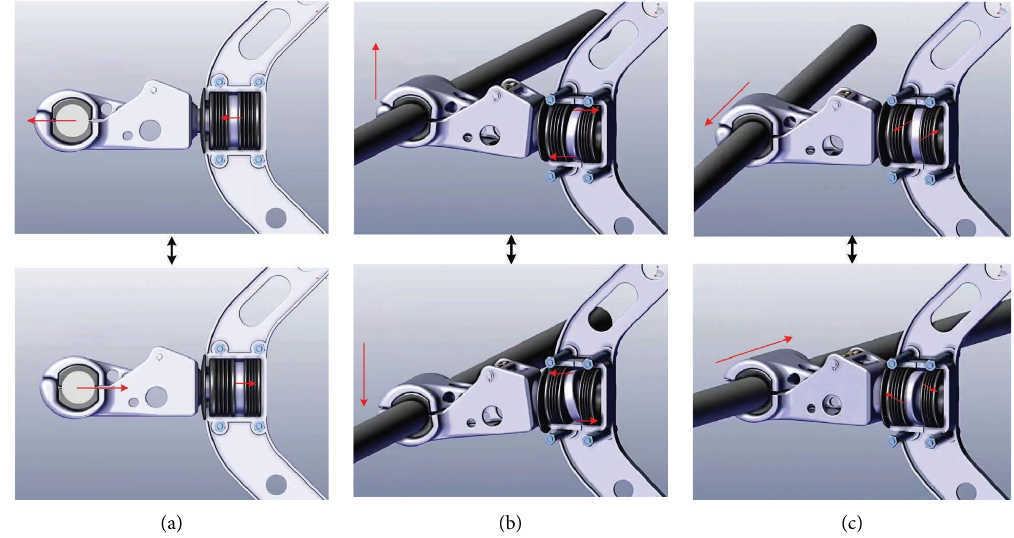
Figure 8: Schematic diagram of structural changes inside the damping joint when the relative motion of the bundle conductor occurs: (a) horizontal relative motion, (b) vertical relative motion, and (c) longitudinal relative motion.